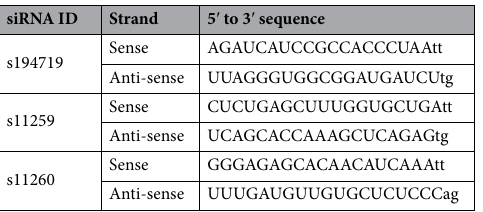
Table 4. Sequences of siRNA against PRSS3 (Ambion, Life